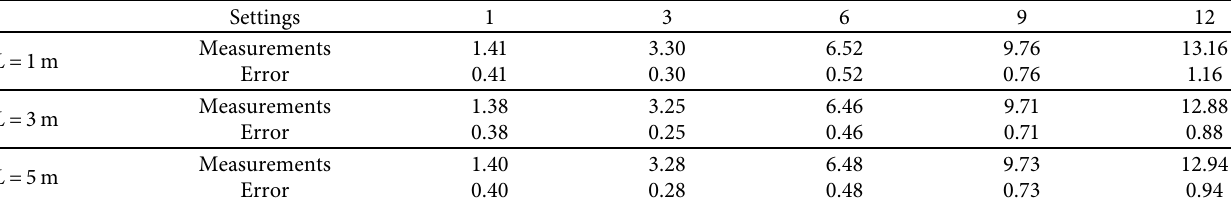
Table 4: Source location results based on target eigenfrequencies.